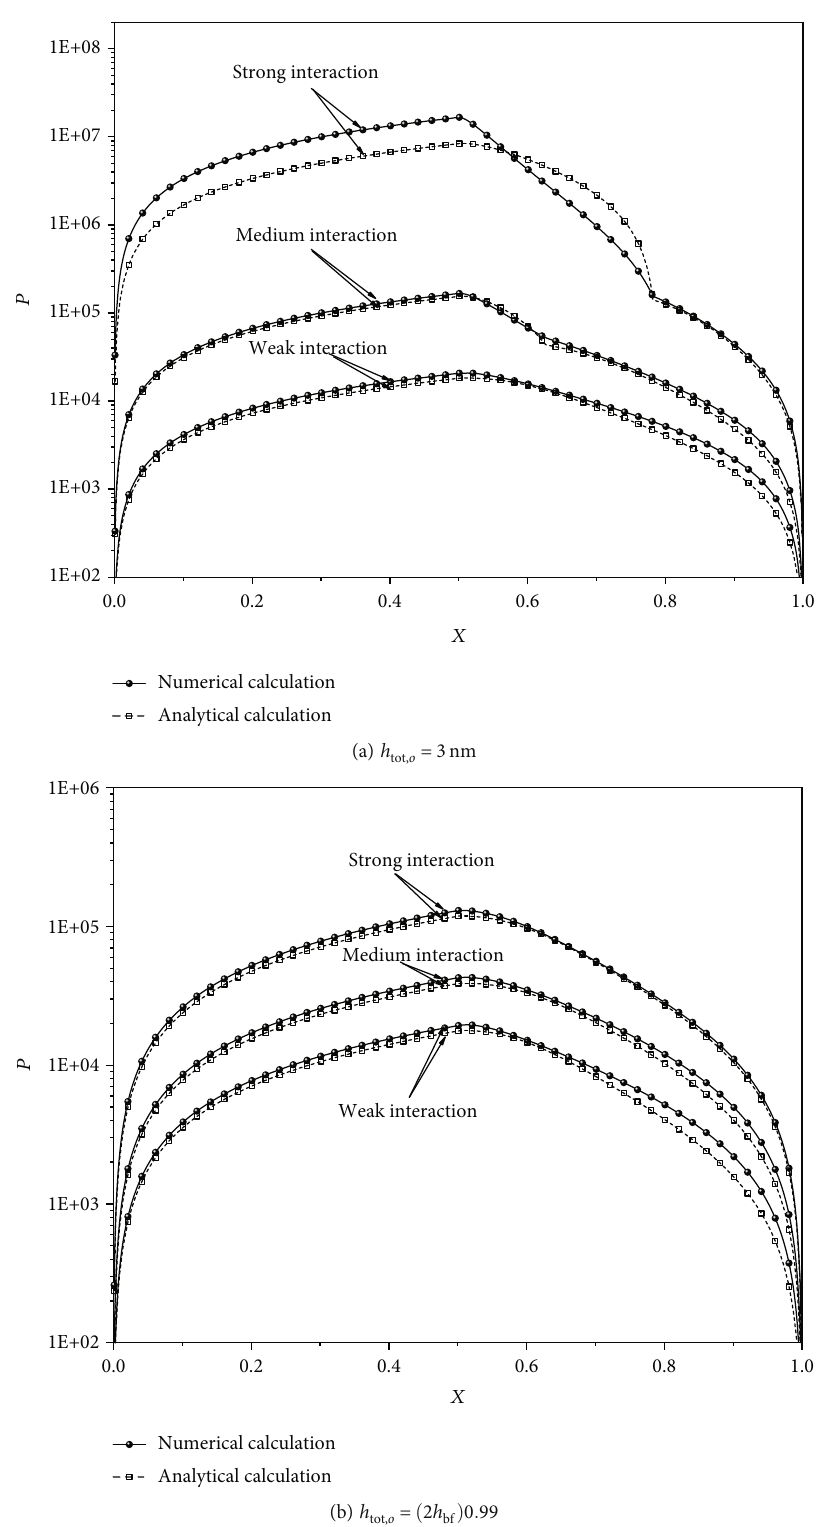
Figure 8: Comparisons of the analytically calculated pressures in the present model of the bearing with the full numerical calculation results for di ff erent fl uid-bearing surface